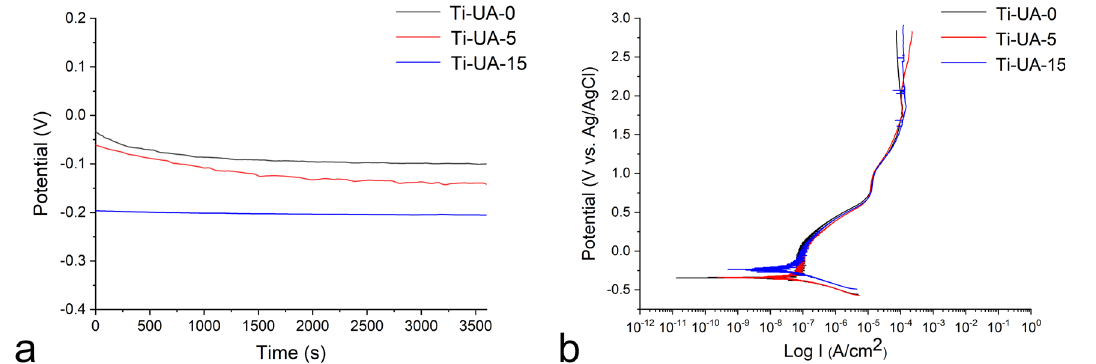
Fig. 4 Representative OCP curve and typical diagram of the potentiodynamic polarization for different titanium samples. a OCP curve; ( b ) potentiodynamic polarization curve